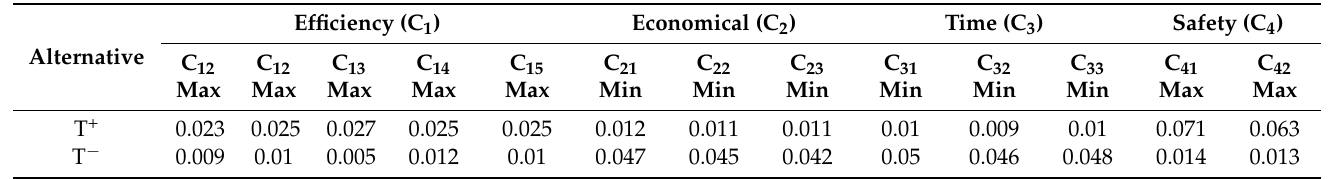
Table 22. The P-I and N-I solution of the considered BPM tool alternatives.